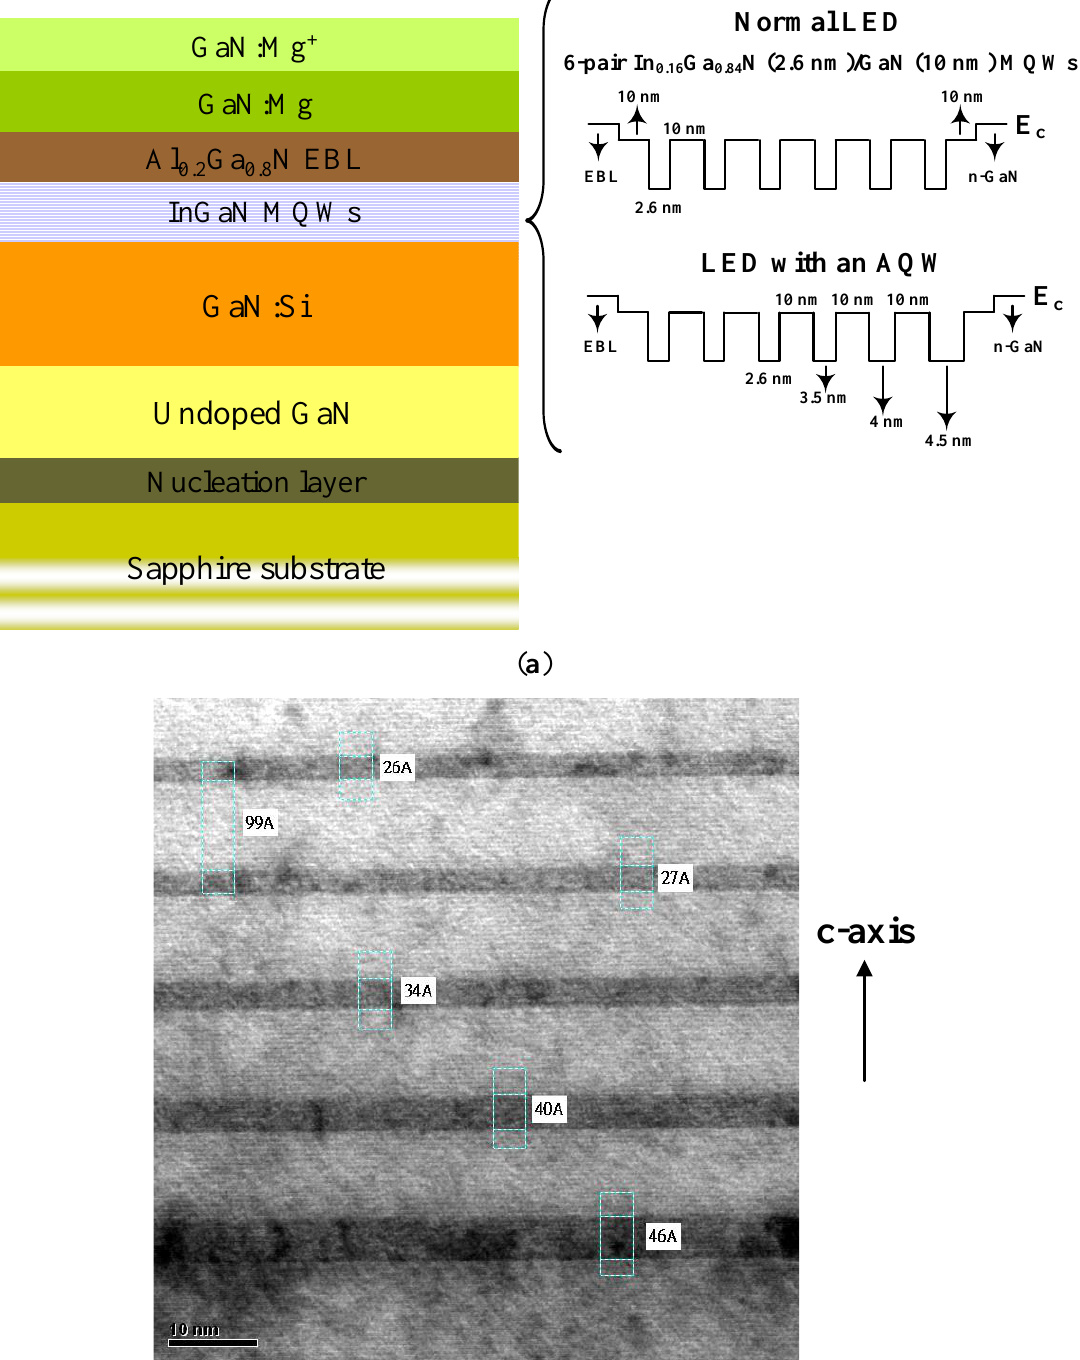
Figure 6. ( a ) Schematic cross-sectional diagram of the epitaxial structures. In comparison with normal LEDs which have a six-pair In multiple-quantum-well (MQW), the proposed LEDs feature a modified MQW in which three InGaN wells adjacent to the n-GaN have a graded thickness while the remaining structure is identical to those of normal LEDs; ( b ) High-resolution transmission electron microscopy (HRTEM) image of the modified MQWs in the LED with an asymmetric quantum well